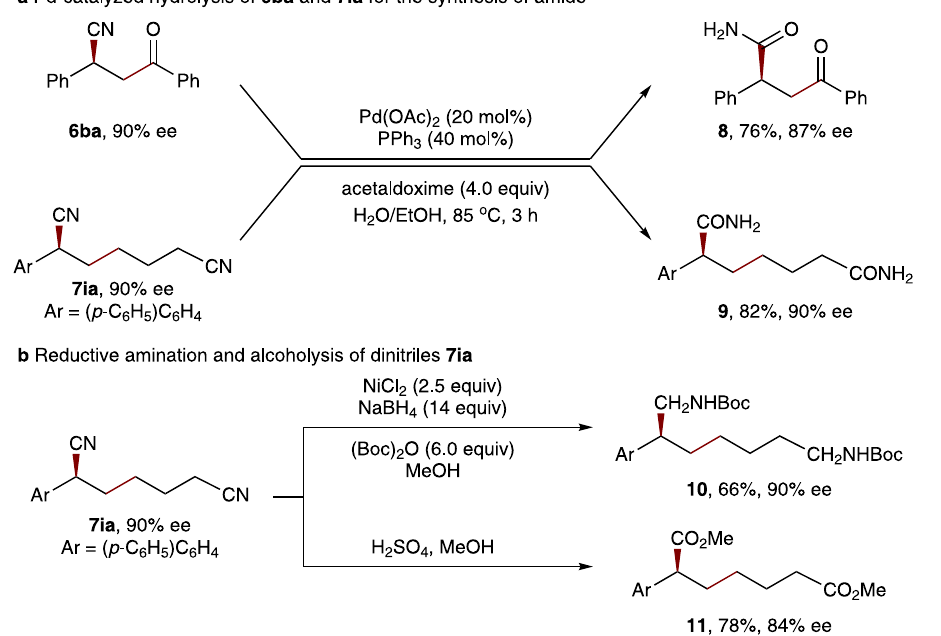
Fig. 6 Synthetic applications. a Pd-catalyzed hydrolysis of 6ba and 7ia for the synthesis of amide. b Reductive amination and alcoholysis of dinitriles 7ia .